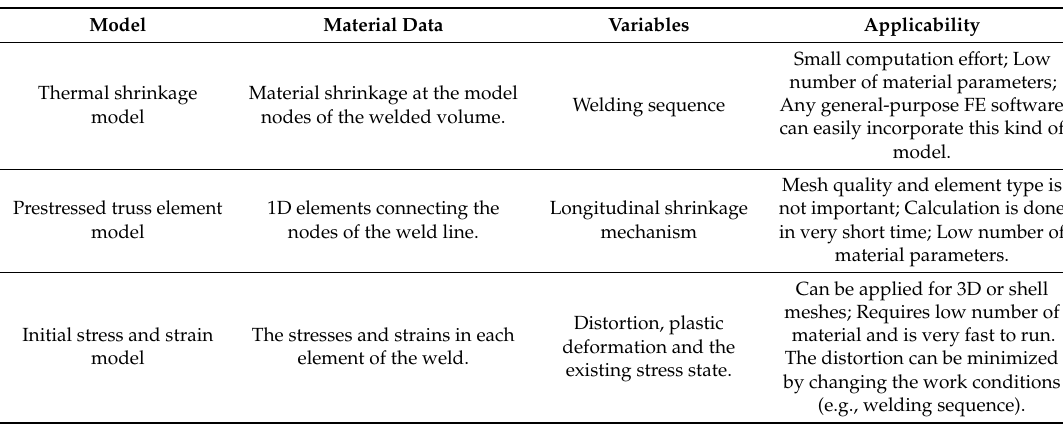
Table 2. Di ff erences between the simplified mechanical